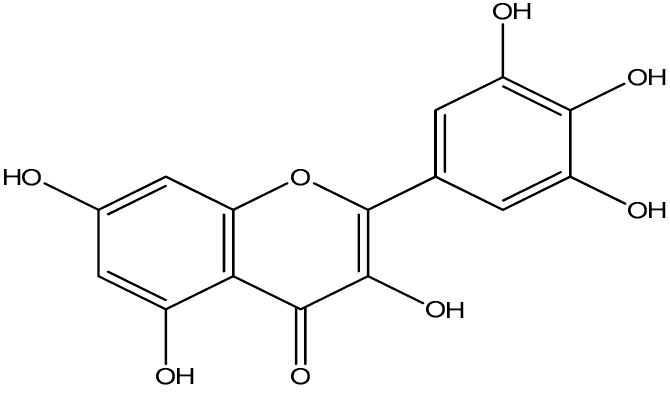
Figure 1. Chemical structure of myricetin isolated from T. capensis.